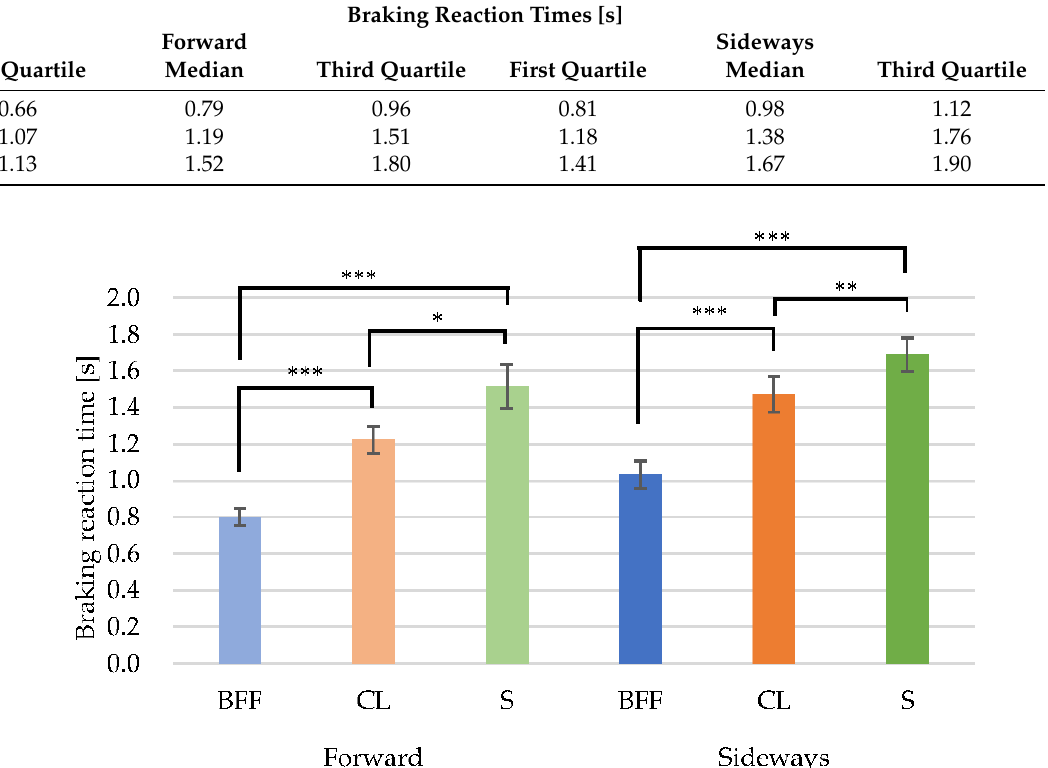
Figure 4. Foot posture comparisons of braking reaction time. ∗ p < 0.05/ ∗∗ p < 0.01/ ∗∗∗ p <